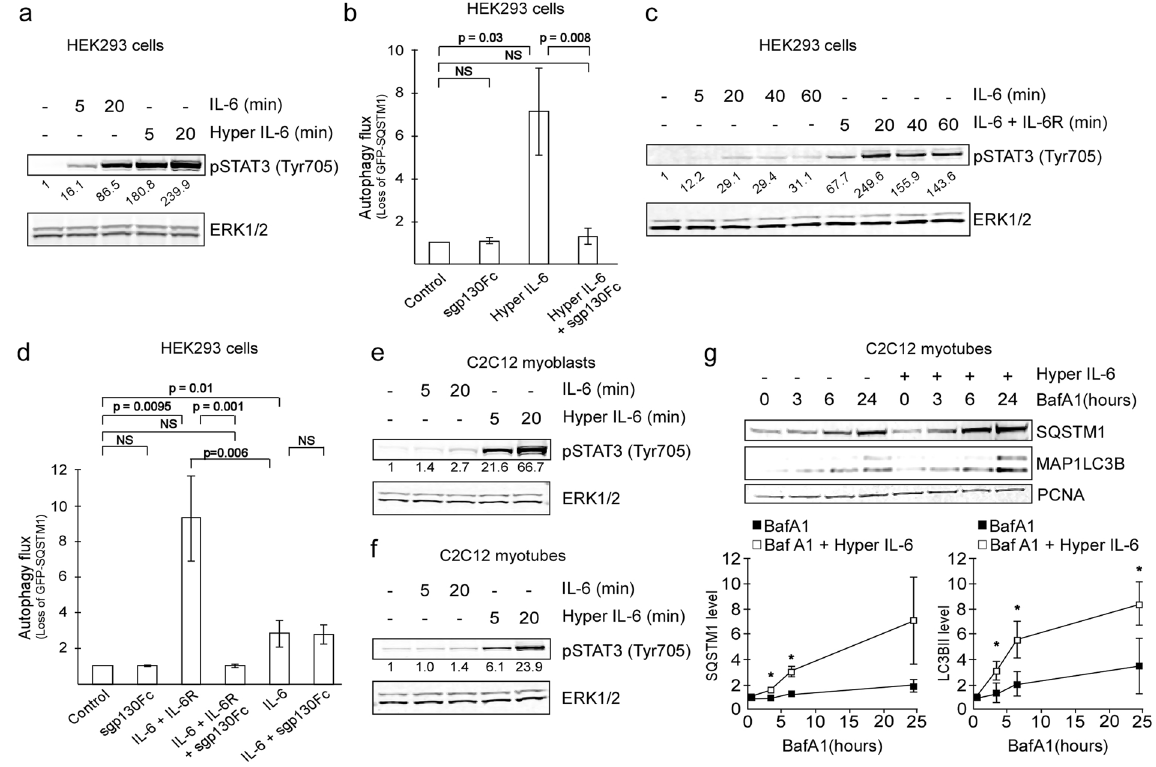
Figure 5. IL-6 trans-signaling accelerates autophagy in myotubes. ( a ) Protein levels of pSTAT3 Tyr705 in HEK293 reporter cells treated with rIL-6 (20 ng/ml) or conditioned medium from hyper IL-6-producing CHO cells (0.1%) as indicated. Protein level from one experiment relative to control and normalized against ERK1/2 as indicated. Results are representative of two independent experiments. ( b ) Autophagy flux in reporter cells following exposure to conditioned medium from hyper IL-6-producing CHO cells (0.1%) and/or sgp130Fc (1 µ g/ml) as indicated. Mean from three independent experiments using duplicate (n = 1) or triplicate (n = 2) wells ± SD. NS = not significant (Student t-test). ( c ) Protein levels of pSTAT3 Tyr705 in HEK293 reporter cells treated with rIL-6 (8 ng/ml) alone or in combination with rIL-6 receptor alpha (IL-6R, 50 × molar excess relative to IL-6) as indicated. Protein level relative to control and normalized against ERK1/2 as indicated. ( d ) Autophagy flux in reporter cells following exposure to rIL-6 (8 ng/ml) and rIL-6 receptor alpha (IL-6R, 50 × molar excess relative to IL-6) and/or sgp130Fc (1 µ g/ml) as indicated. Mean from four (three for sgp130Fc) independent experiments using quadruplicate wells ± SD. NS = not significant (Student t-test). ( e ) Protein levels of pSTAT3 Tyr705 in C2C12 myoblasts treated with rIL-6 (20 ng/ml) or conditioned medium from hyper IL-6-producing CHO cells (0.1%) as indicated. Protein level relative to control and normalized against ERK1/2 as indicated. ( f ) As E, but with C2C12 myotubes. ( g ) Protein levels of MAP1LC3B and SQSTM1 in C2C12 myotubes treated with conditioned medium from hyper IL-6-producing CHO cells (0.1%, 3 days) and BafA1 (100 nM) or BafA1 alone for indicated time periods. MAP1LC3B-II and SQSTM1 signals are normalized against PCNA. Graphs illustrates the mean from three independent experiments ± SD. * p < 0.05 (Student